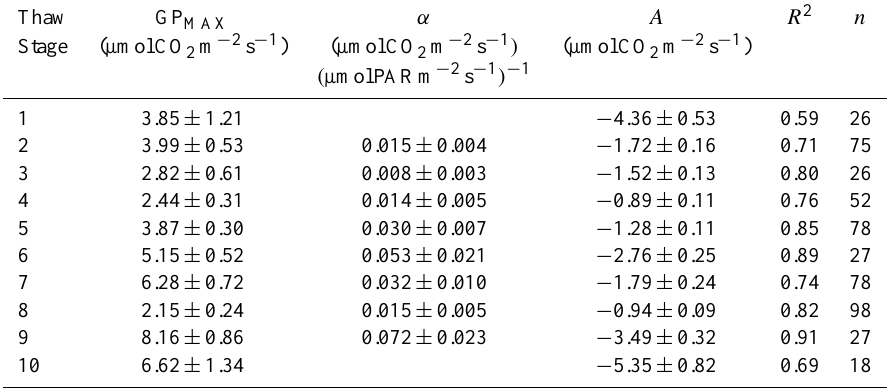
Table 4. Parameter estimates ± standard error from rectangular hyperbola fit of NEE and PAR. PAR dependence of NEE generally increases and becomes more significant from less to more thawed stages as shown by the adjusted R 2 ( p < 0 . 0001 for all thaw stages). There is a general trend of increasing, GP MAX , α and A , going from less thawed to more thawed stages. Thaw GP MAX α A R 2 n Stage (µmolCO 2 m − 2 s − 1 ) (µmolCO 2 m − 2 s − 1 )